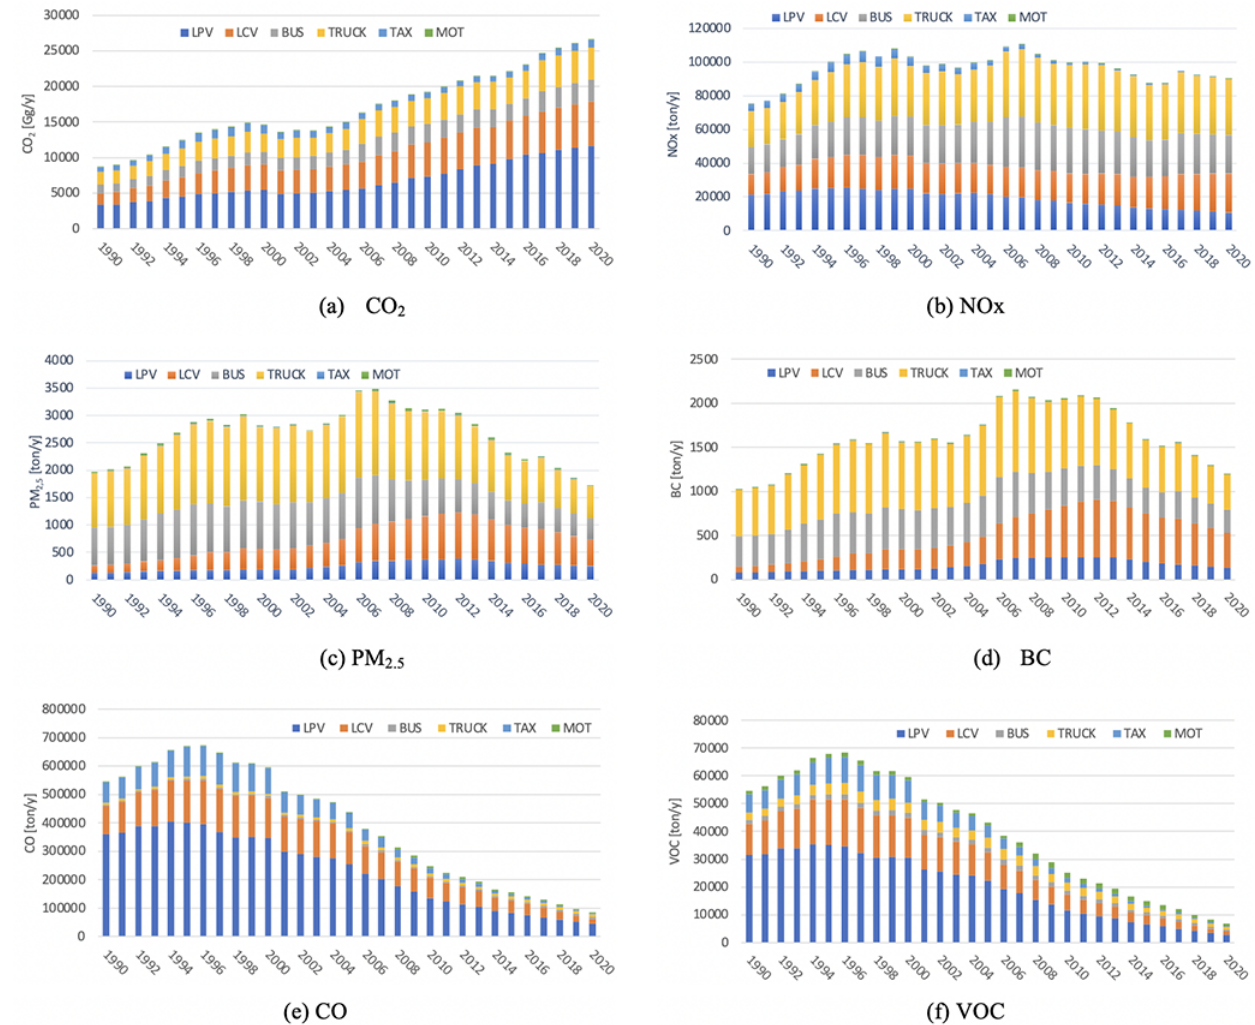
Figure 5. Total annual exhaust emission trends according to vehicle type in Chile,